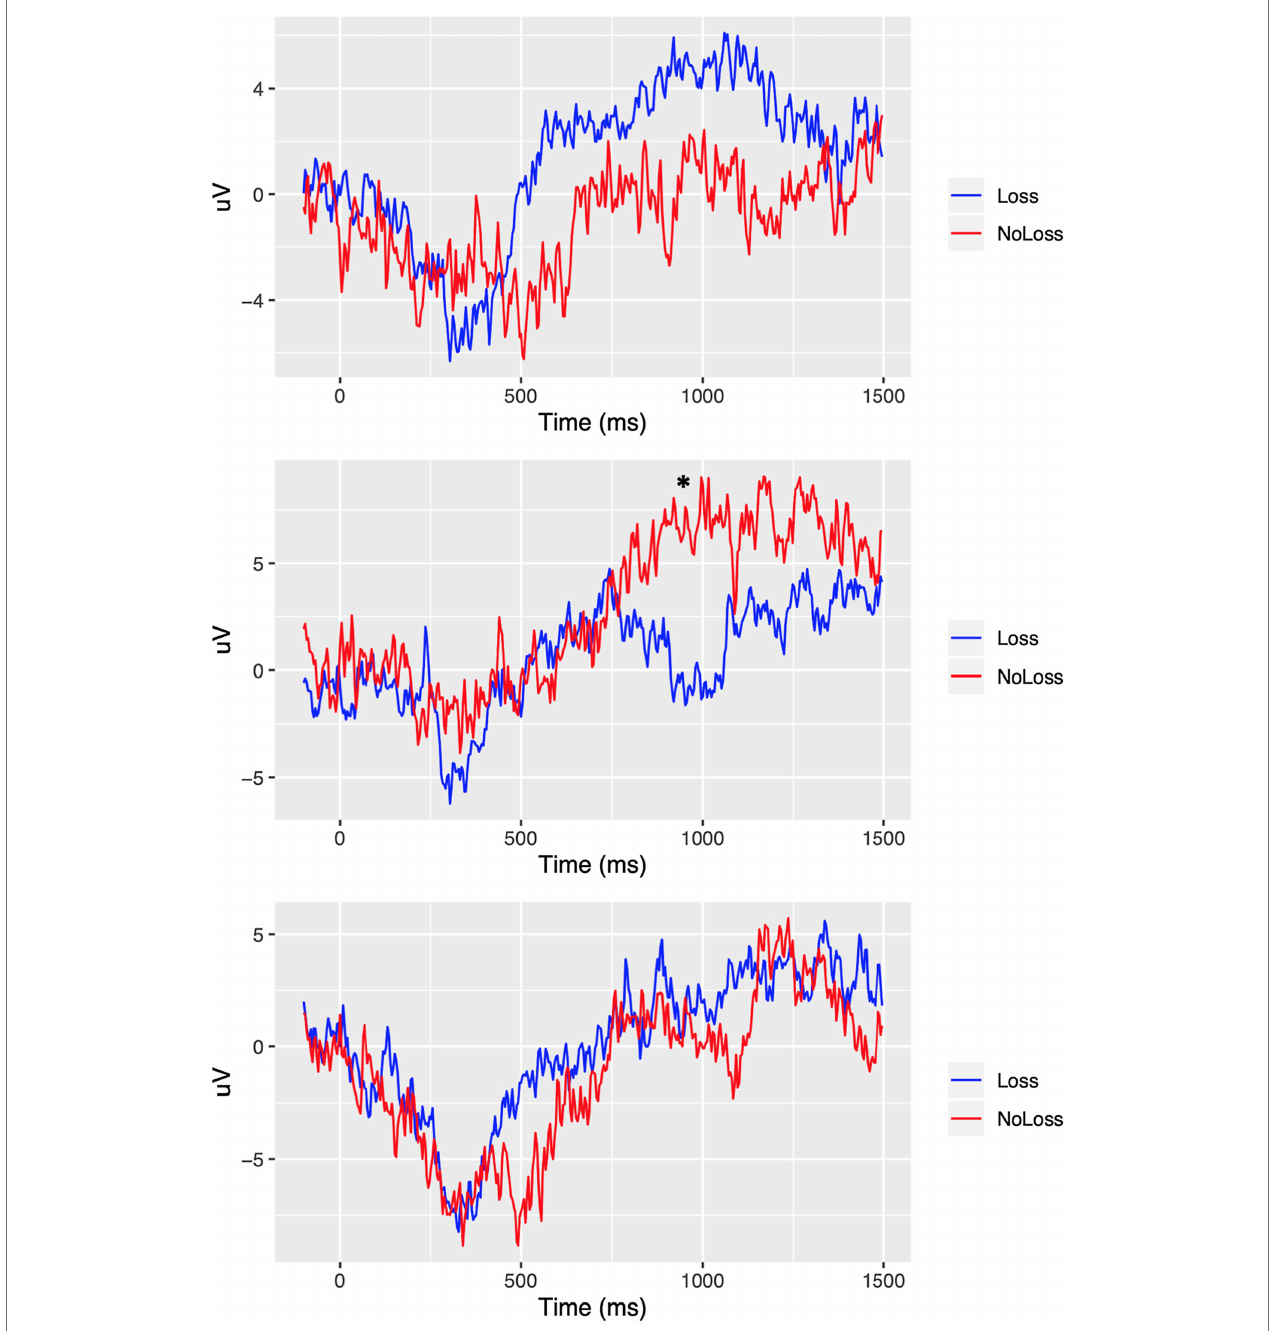
FIGURE 4 | ERP comparison in Fp2 between Loss versus No-Loss groups. Top: physical-pain condition. Middle: psychological-pain condition. Bottom: non- painful condition. * represents a significant different at p < 0.05 (FDR